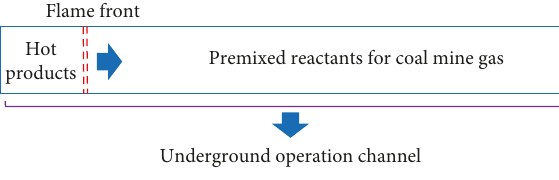
Figure 1: Physical model of deflagration process in the